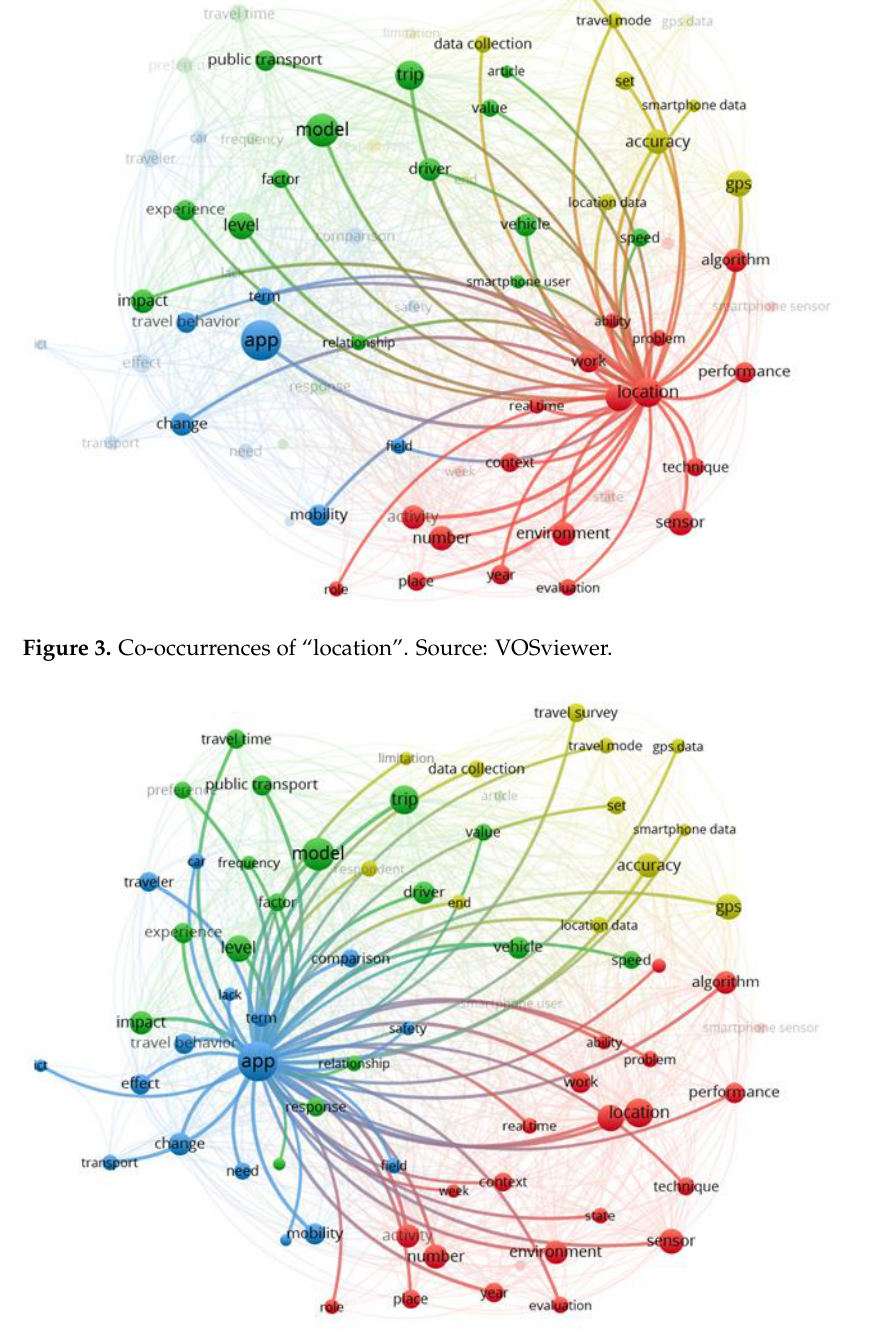
Figure 4. Co-occurrences of “ app ” . Source: VOSviewer.